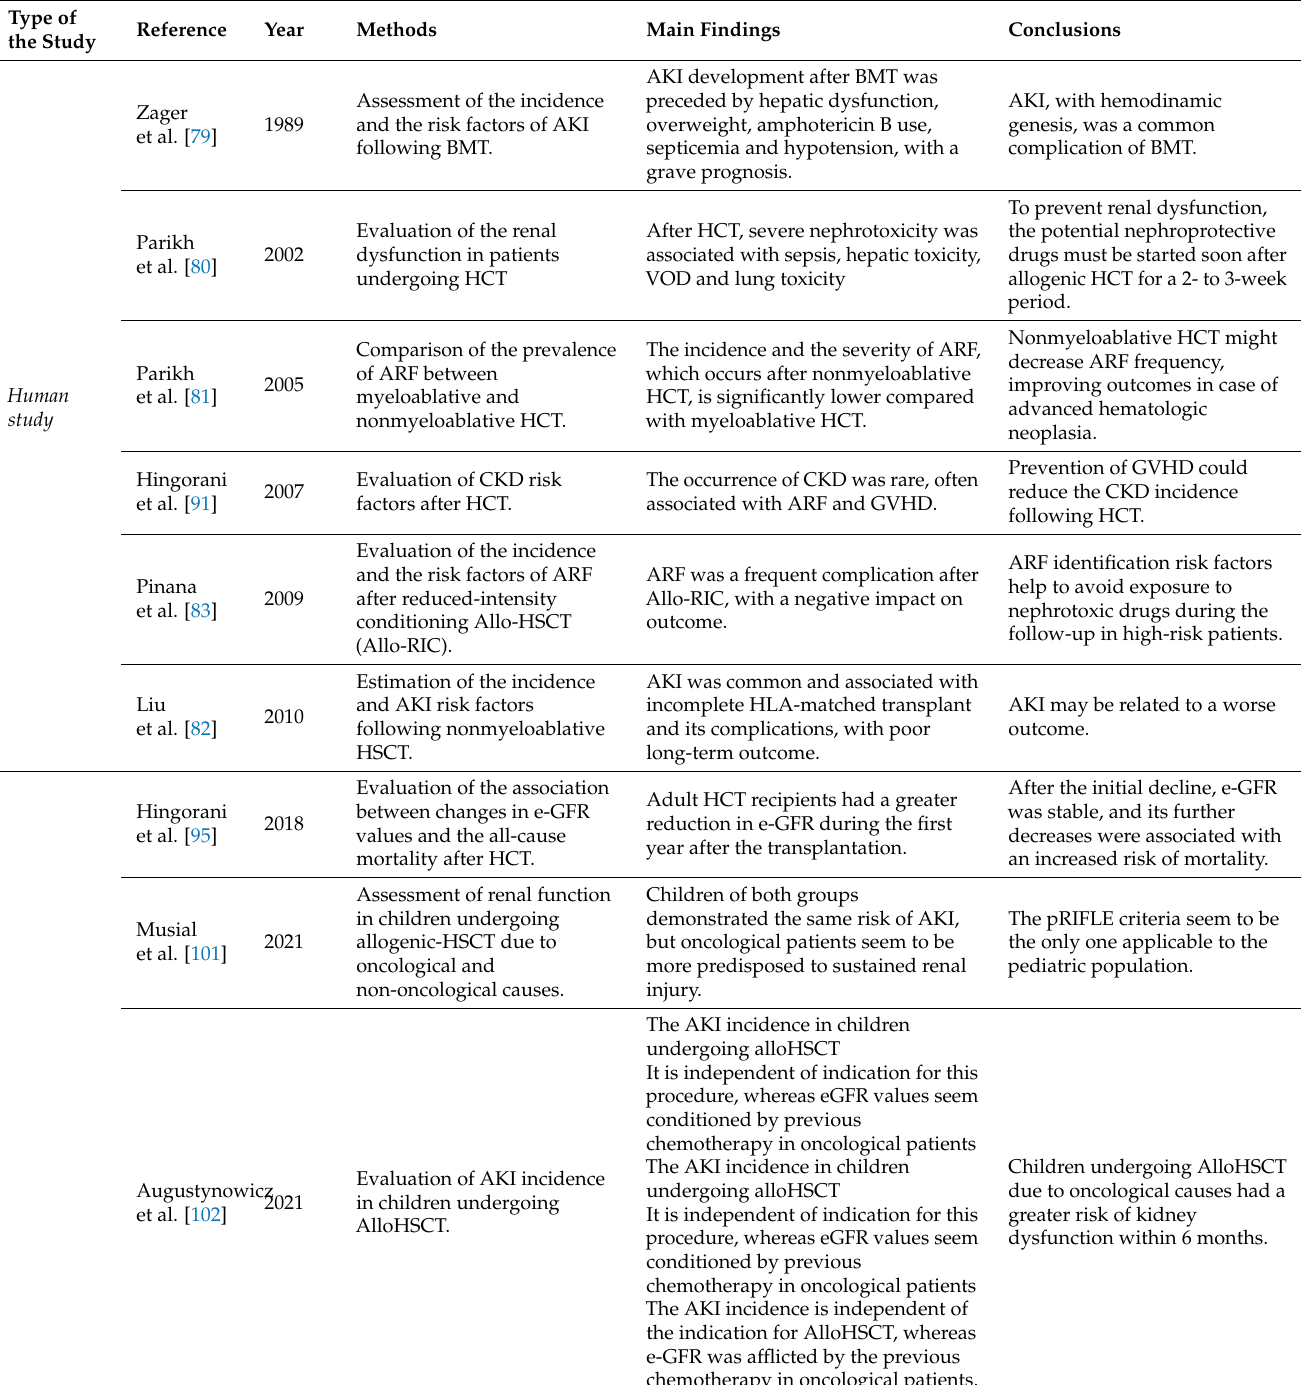
Table 3. Main studies on kidney dysfunction after hematopoietic stem cell